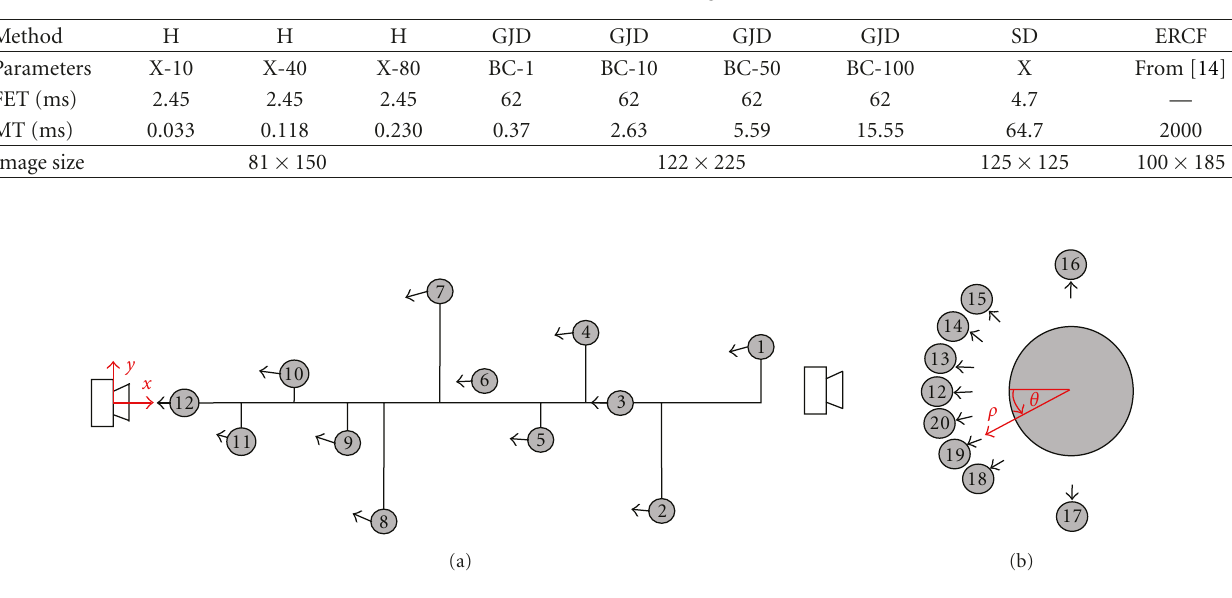
Table 5: Processing Time. Time measures are in milliseconds. We carried out the experiments on a computer running Linux with an Intel